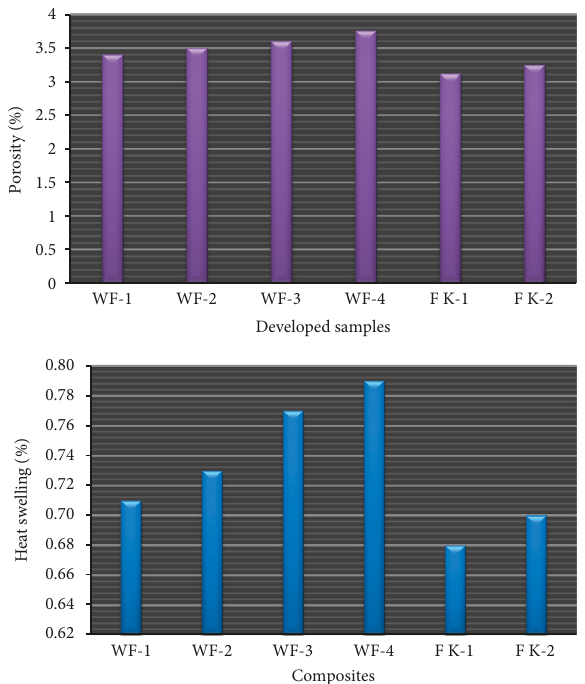
Figure 3: Porosity and heat swelling of newly developed composites.